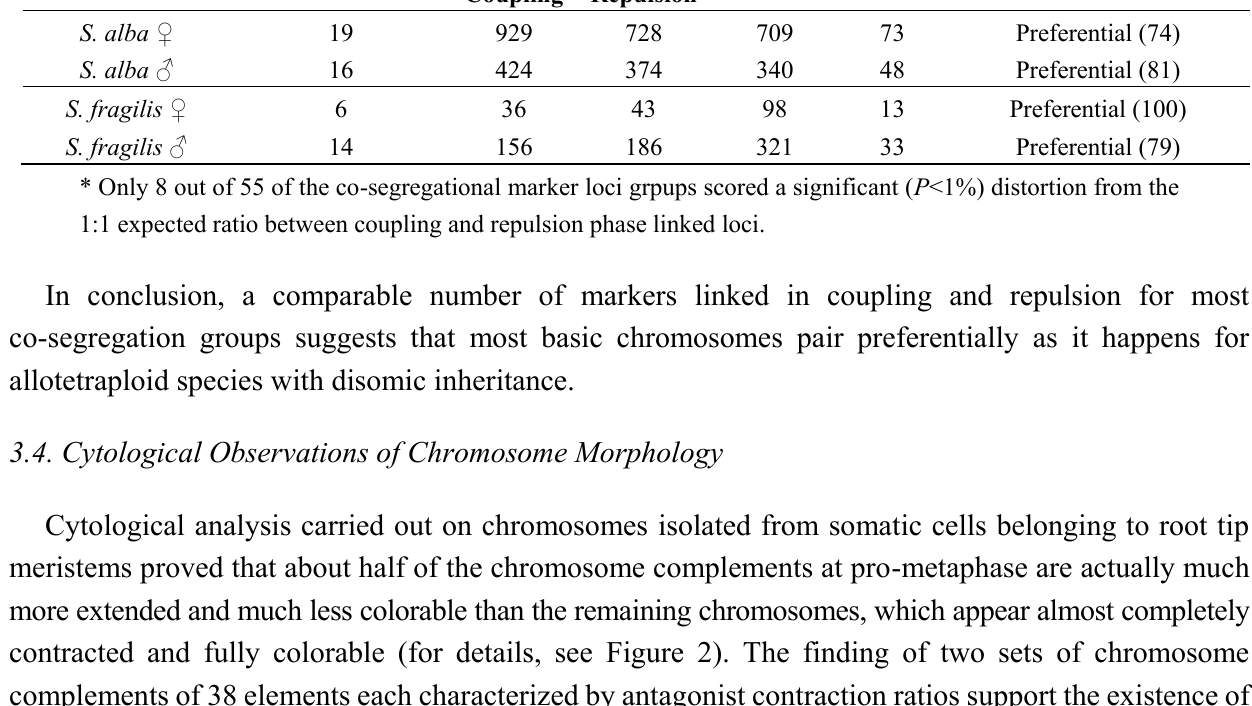
Table 2. Main statistics about linkage phase (coupling vs. repulsion) of marker loci belonging to S. alba and S. fragilis co-segregational female and male linkage groups. A comparable number of markers linked in coupling and repulsion were found for most linkage groups, suggesting that basic chromosomes pair preferentially as occurs for allotetraploid species with disomic inheritance. Linkage Phase Species (Gender) Linkage Groups * Size (cM) No. loci Chromosome Pairing (%) Coupling Repulsion 929 728 709 73 Preferential (74) 424 374 Preferential (100) 156 186 321 33 Preferential